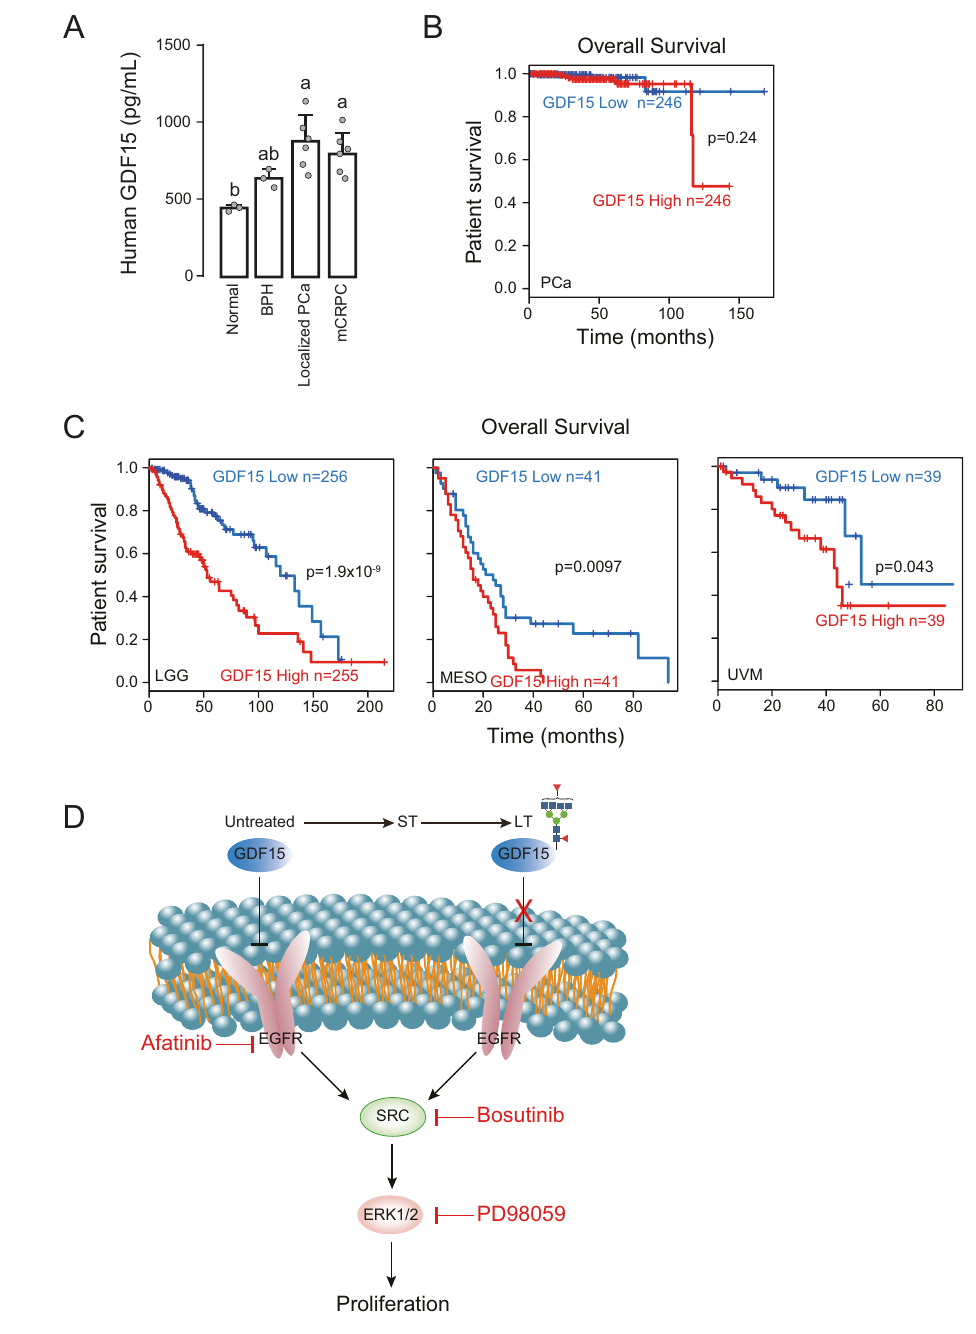
Fig. 7 High level of GDF15 glycoprotein expression is associated with poor survival of cancer patients. A GDF15 level was determined by ELISA in serum samples from normal and patients with BPH, Localized PCa, or mCRPC. One-way ANOVA, p < 0.05. Data are expressed as mean ± std. B Prostate cancer patient overall survival curve in relation to GDF15 expression level was calculated using data from the Gene Expression Pro fi ling Interactive Analysis (EGPIA) website. C Overall survival curves of lower grade glioma (LGG), mesothelioma (MESO), and uveal melanoma (UVM) patients in relation to GDF15 expression level were obtained from the EGPIA website. P -values were calculated using log-rank test; meta-analysis survival plots were generated using KM plotter. D Schematic graph depicts GDF15 inhibition of EGFR and N-glycosylation of GDF15 disables its suppressive effect on the EGFR pathway in CRPC cells. “ pheatmap ” function from the “ pheatmap ” R-package (https://www.r- enrichment of pathway analysis, Kyoto Encyclopedia of Genes and Genomes (KEGG) database (https://www.genome.jp/kegg/) was used to project.org/). identify enriched pathways by a two-tailed Fisher ’ s exact test to detect the enrichment of differentially expressed protein against all quantitative Quantitative real-time PCR glycoproteins. Pathways with a corrected FDR ≤ 0.05 were considered LNCaP Cells were cultured with c-FBS for 5 days before treatment with signi fi cant, and classi fi ed into hierarchical categories. Furthermore, DMSO + ENZ/EPI or R1881 + ENZ/EPI for 12 h. Total RNA was extracted proteins in selected pathways were visualized by a heat map using the Cell Death and Disease (2022)